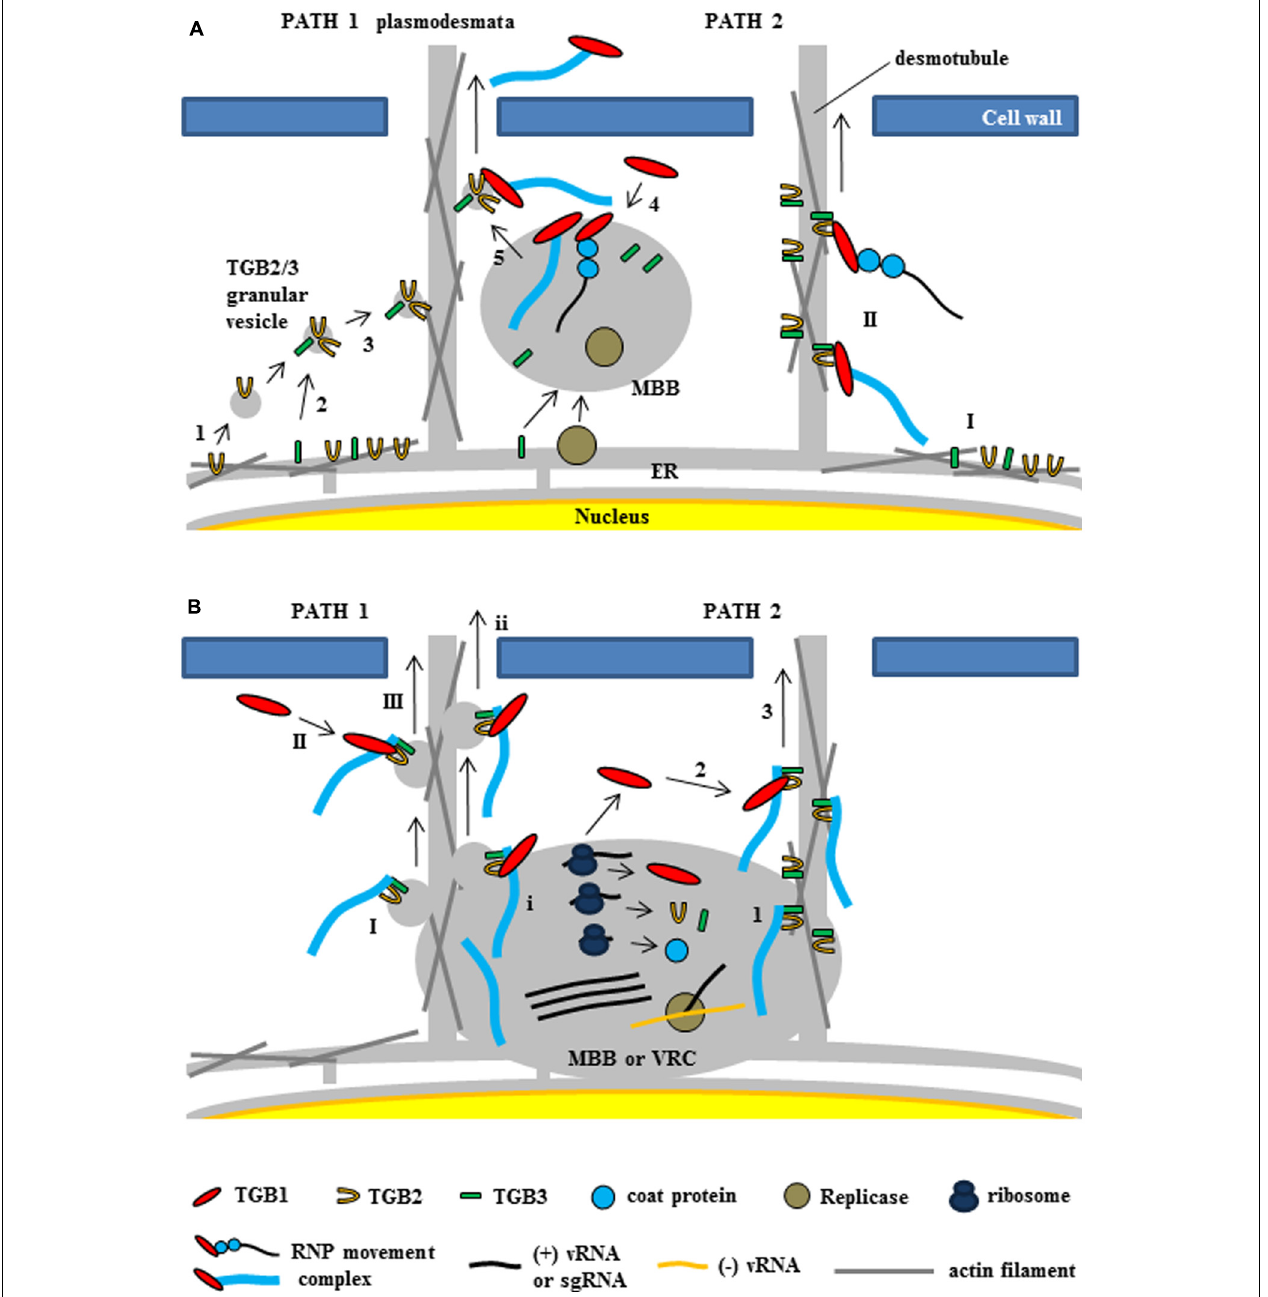
FIGURE 5 |Two models for intracellular trafficking of potexviruses. These two models were partially adapted from Chou etal. (2013) and Verchot-Lubicz etal. (2010). (A) The first model proposed by Verchot-Lubicz etal. (2010). (PATH 1) Potexvirus RNP movement complex is trafficked by TGB2-induced granular vesicles with TGB3 protein (TGB2/3 granular vesicles) to the PD. TGB2 protein is able to induce the formation of granular vesicles derived from the ER membranes (1) and colocalizes with TGB3 protein (2). TGB3 protein directs movement of the TGB2-induced granular vesicles from the perinuclear ER to the cortical ER (3). vRNA or virion form of potexvirus mainly associates with membrane-bound bodies (MBB) derived the perinuclear ER that contains replicase and TGB3 protein. TGB1-bound vRNA or virion form (RNP movement complex released from MBB by TGB3 protein (4) and binds to TGB2/3 granular vesicles in the ER